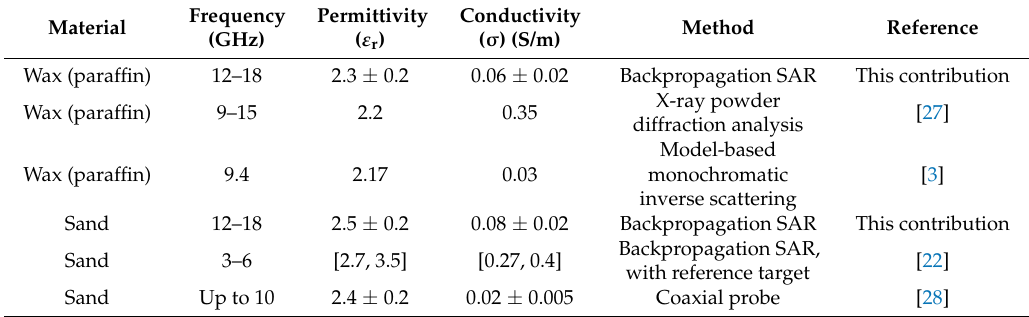
Table 1. Constitutive parameters of the media considered in the examples. Comparison with other techniques at microwave